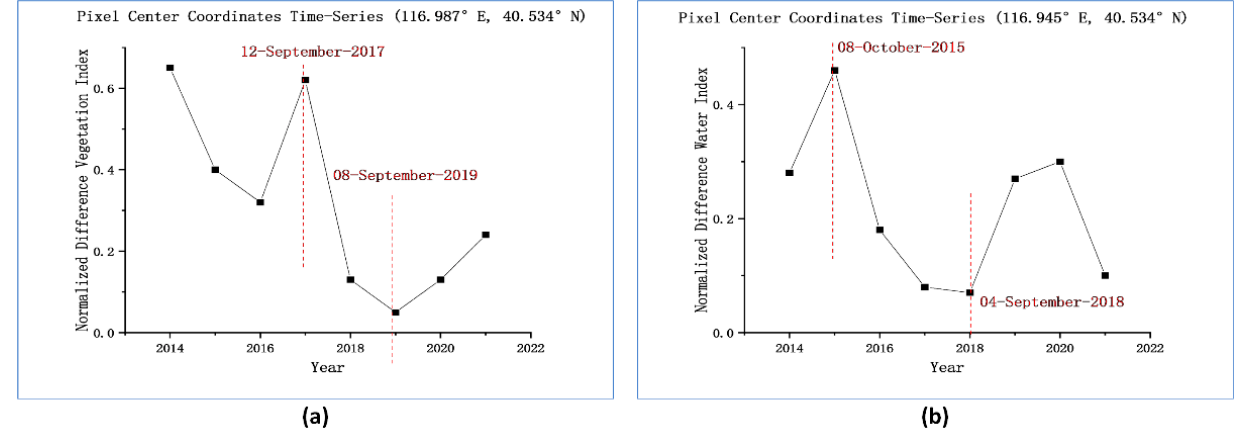
Figure 7. NDVI and NDWI time series of sampling sites on the Miyun Reservoir. ( a ) Annual change curves of NDVI time series for the selected sample points (116.987° E, 40.534° N) from 2014 to 2021. ( b ) Annual change curves of NDWI time series for the selected sample points (116.945° E, 40.534° N) from 2014 to 2021.